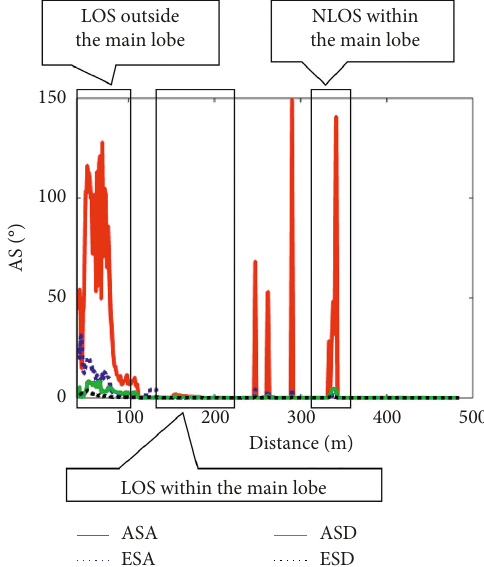
Figure 15: AS of urban environments in both azimuth and elevation domains.